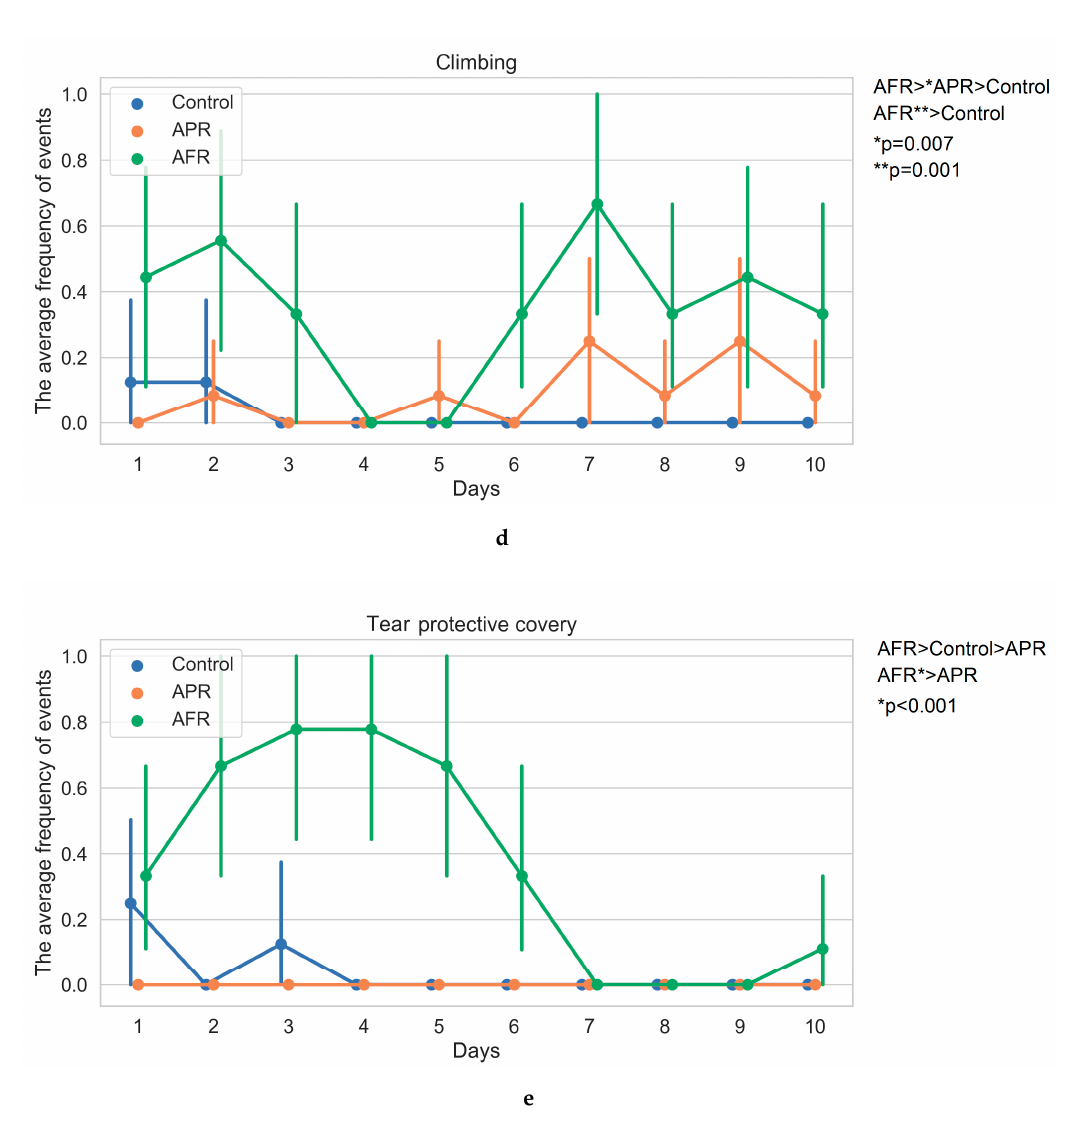
Figure 1. Behavior patterns of allostatic flight/fight/active (AFR) or allostatic freezing/passive (APR) response rats. Legend: Bonferroni’s calculations for M ± SE of ( a ) the frequency (per rat) of freezing behavior acts, ( b ) the frequency (per rat) of grooming behavior acts, ( c ) The frequency (per rat) of sniffing acts, ( d ) the frequency (per rat) of climbing acts, ( e ) the frequency (per rat) of attempts to tear the protective material of the Petri dishes.